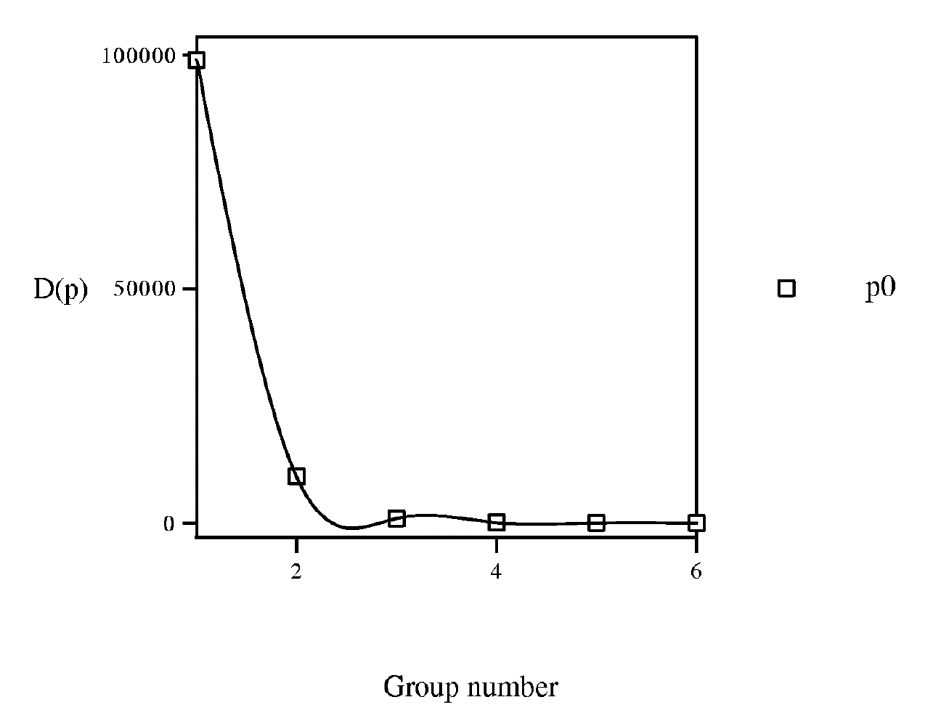
Figure 13. Variation of property D ( p ) = P ( p + 1) − P ( p ) versus group. P : vector